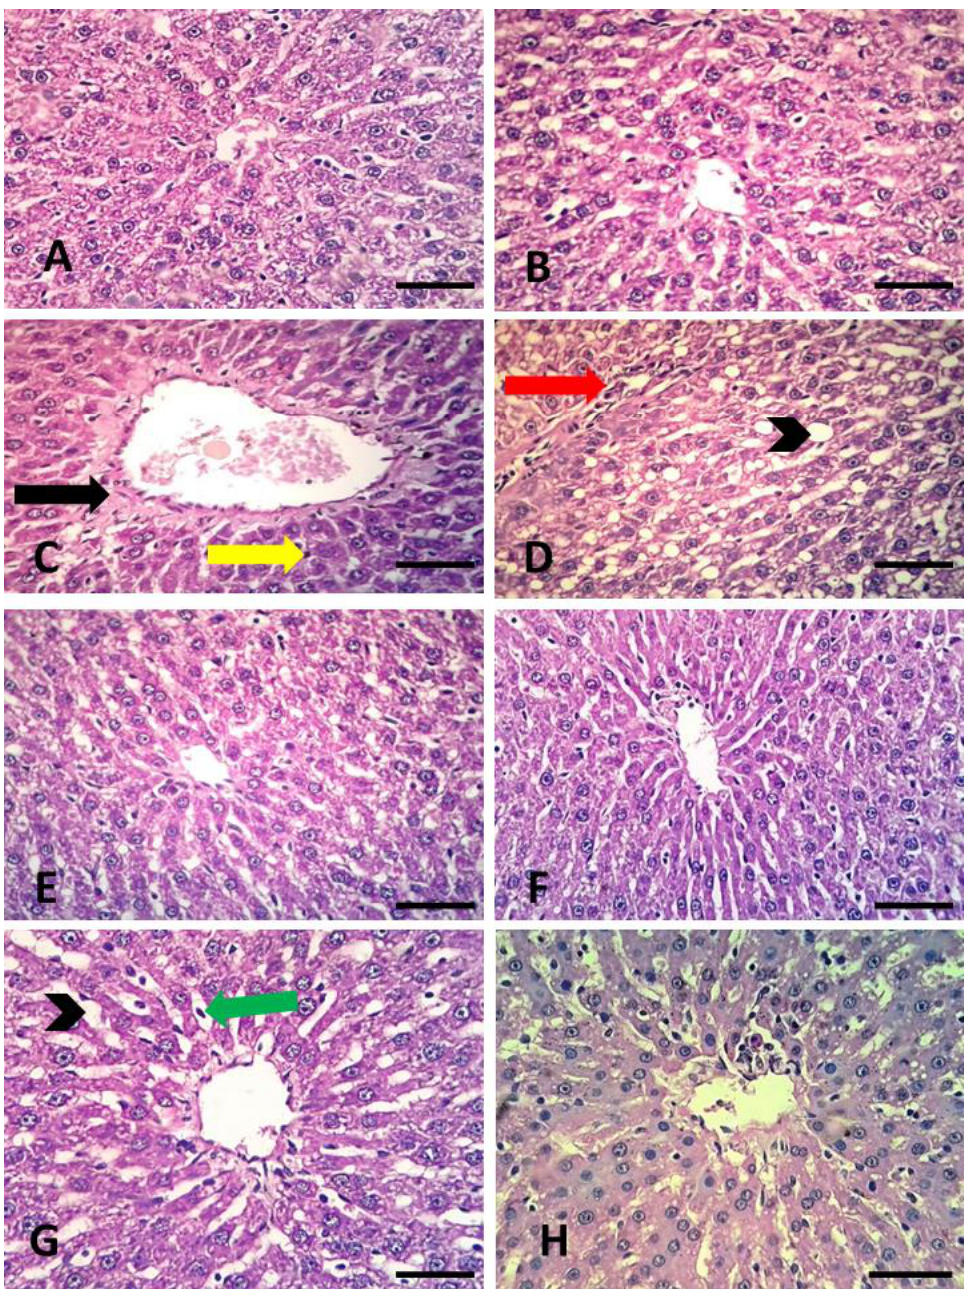
Figure 3 . Microscopic pictures of liver sections showing a normal radial arrangement of hepatic cords around central veins with normal sinusoids in the ( A ) distilled water group and ( B ) the group of tap water. Liver sections from the control + group ( C , D ) showing increased collagen fibres around the central vein (black arrow), circulating leukocytes (yellow arrow), droplets of lipid (head arrow), and infiltration of lymphocytes (red arrow). Liver sections from the group that received ( E ) 250 and ( F ) 500 mg wheat grass and ( H ) 500 mg barely grass appear normal, except for ( G ) 250 mg barely, which had dilatation in the sinusoids (head arrow) and infiltration of lymphocytes (green arrow). H&E 400; scale bar = 40 micron.